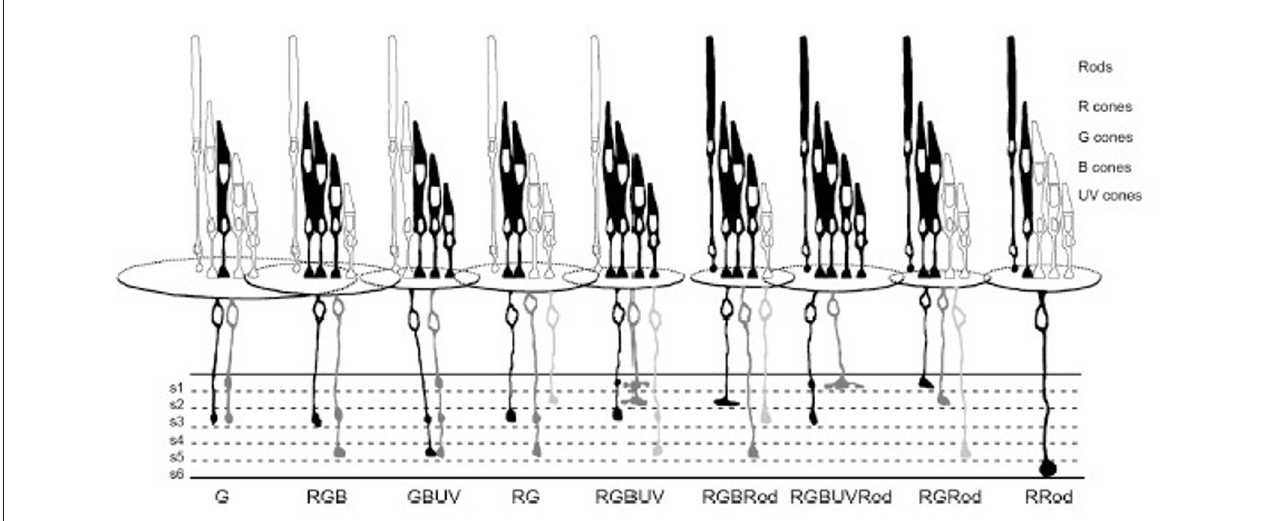
FIGURE 4 | Bipolar cells make diverse connections with PRs. Summary figure (reproduced with permission from Li et al., 2012) showing the different PR connections associated with morphologically-distinct types of BCs. Each BC was identified by axon terminal ramification within the six sublaminae (s1–s6) of the inner plexiform layer (IPL) and by dendritic connections with specific cone types. Most BC types make connections with multiple (>2) PR types, except for two types that exclusively contact green cones (at left of figure) Rod, contacts rods; R, red cones; G, green cones; B, blue cones; UV, UV cones. Shading reflects frequency of identification of a given type, with the darker (black) color indicating the most commonly observed type.